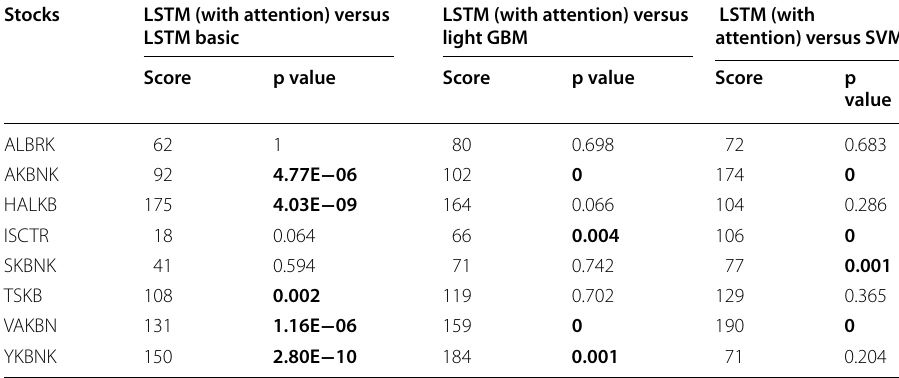
Bold numbers indicate the best performance